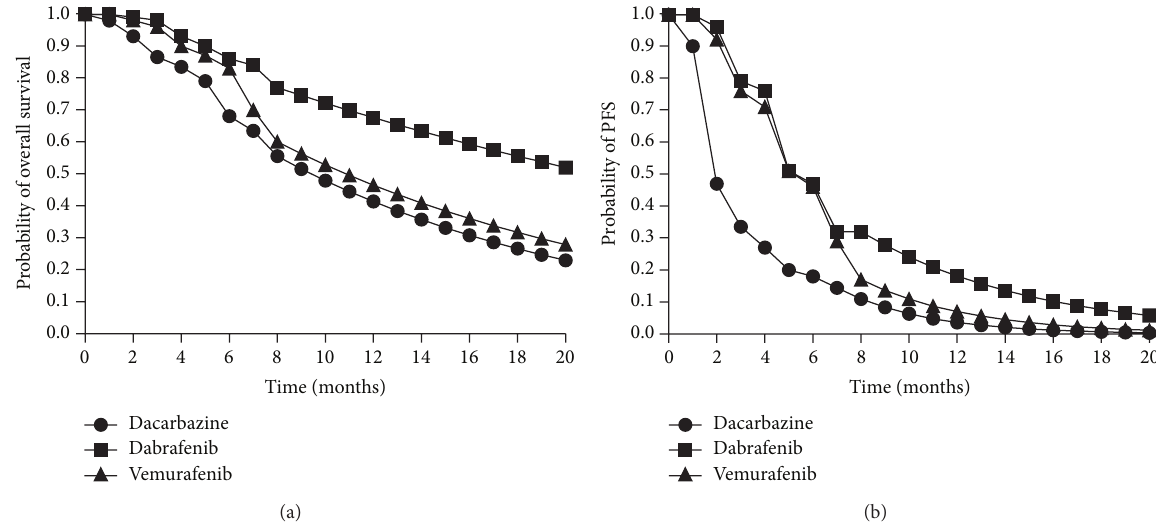
Figure 2: (a) Kaplan-Meier Overall Survival Curve. (b) Kaplan-Meier Progression-Free Survival Curve. (The probabilities from 0–8 months are from clinical trial data. The probabilities from 8 months to end of life are modeled using the DEALE method.)